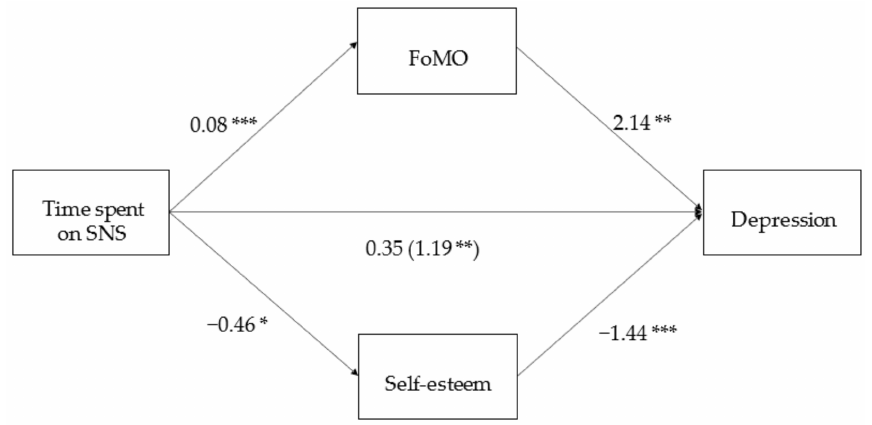
Figure 3. FoMO and Self-esteem as mediators in the relation between Time spent on SNS and Depression. Note: p < 0.001 ***, p < 0.01 **, p < 0.05